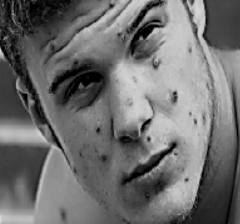
Figure 6. A Monkeypox image was employed as a message to be embedded in the cover